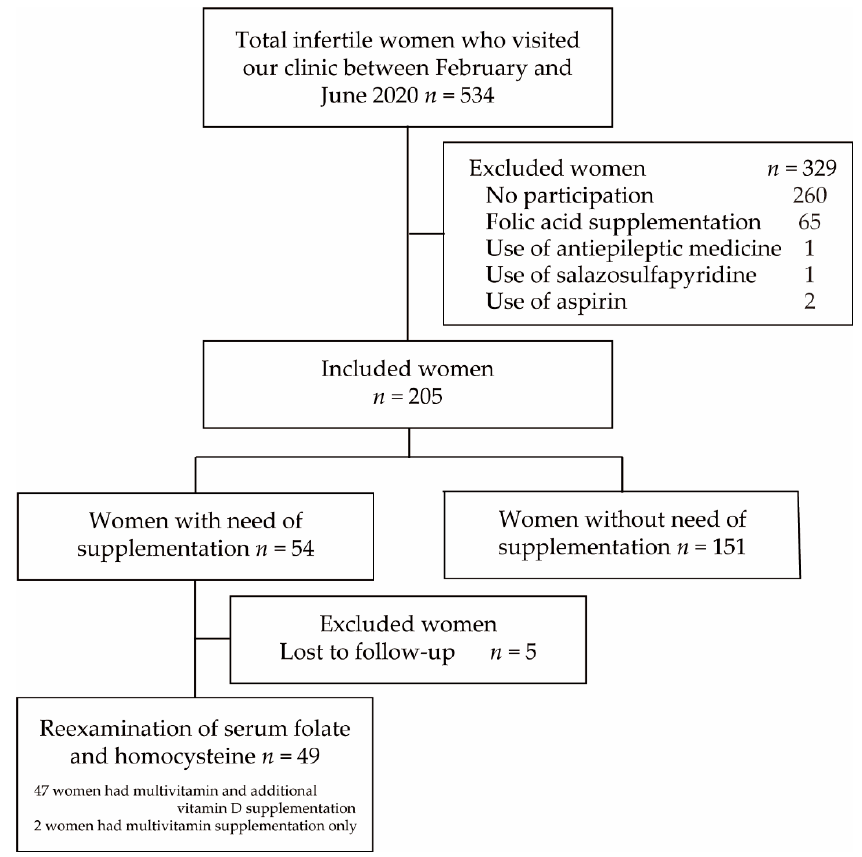
Figure 2. Flowchart of patient selection. Of the 534 consecutive infertile Japanese women who visited our clinic between February and June 2020, 205 were recruited after excluding 329 who refused participation ( n = 260) and had folic acid supplementation ( n = 65) and/or drugs that potentially inhibit folate absorption or conversion to its active form, including antiepileptic medications ( n = 3) and anti-inflammatory drugs, such as sulfasalazine ( n = 1) and aspirin ( n = 2). Of the recruited women, 54 with serum folate levels of <7.0 ng/mL and/or hyperhomocysteinemia with homocysteine levels of >13.5 nmol/mL received daily multivitamin supplementation. After excluding five women without follow-up, 49 underwent remeasurement of folate and homocysteine levels after one